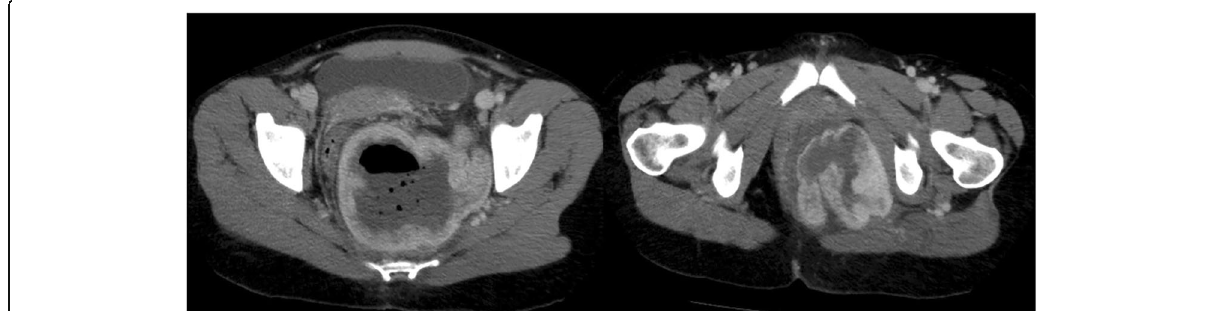
Fig. 4 Atypical presentation of a SFT of the pelvis. Axial CT images showing a large heterogeneous mass with central necrosis and thick walls. It was biopsy proven to be a SFT of the